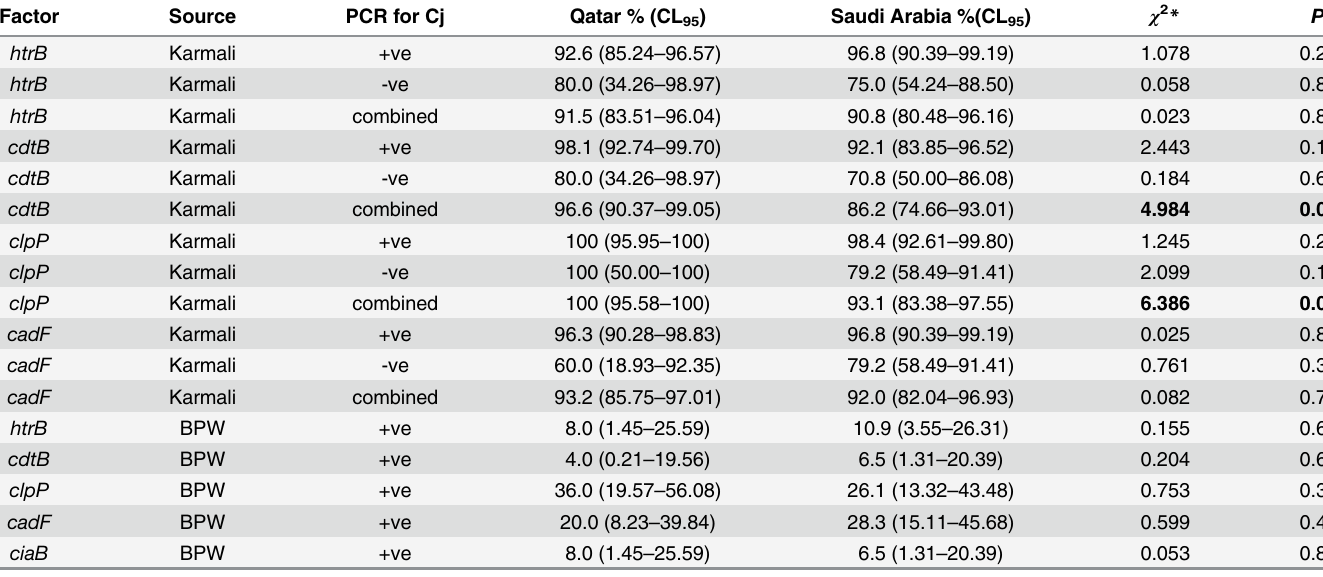
Table 5. Comparison of prevalence (%) of virulence factors on chickens supplied by Qatari and Saudi Arabian producers.